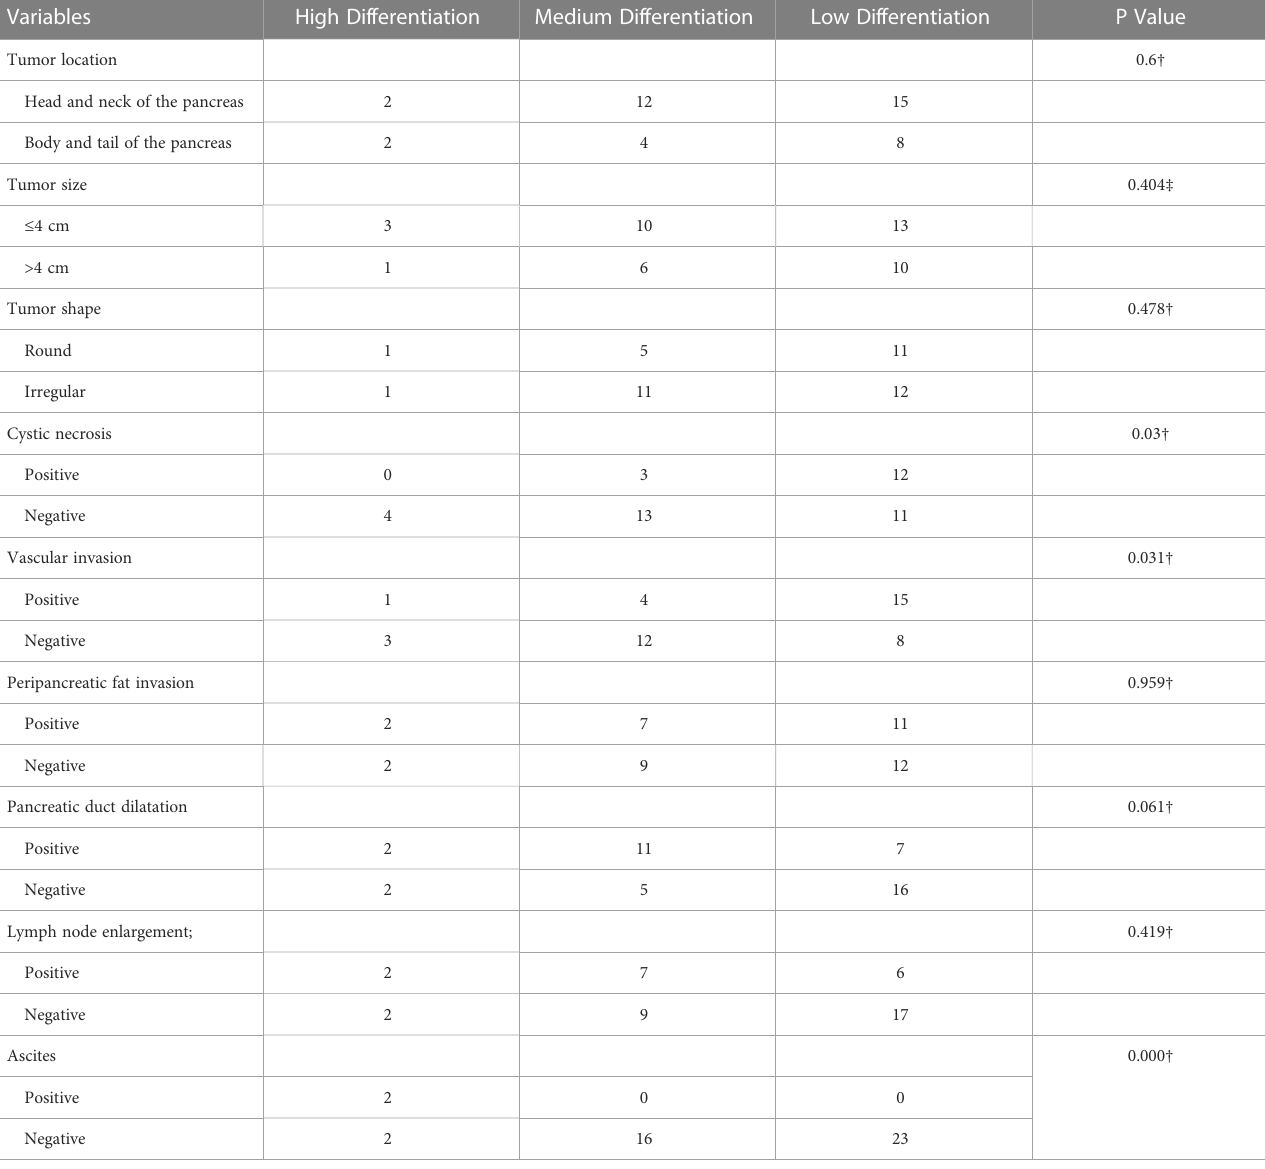
TABLE 1 Correlations between radiologic features and pathological differentiation